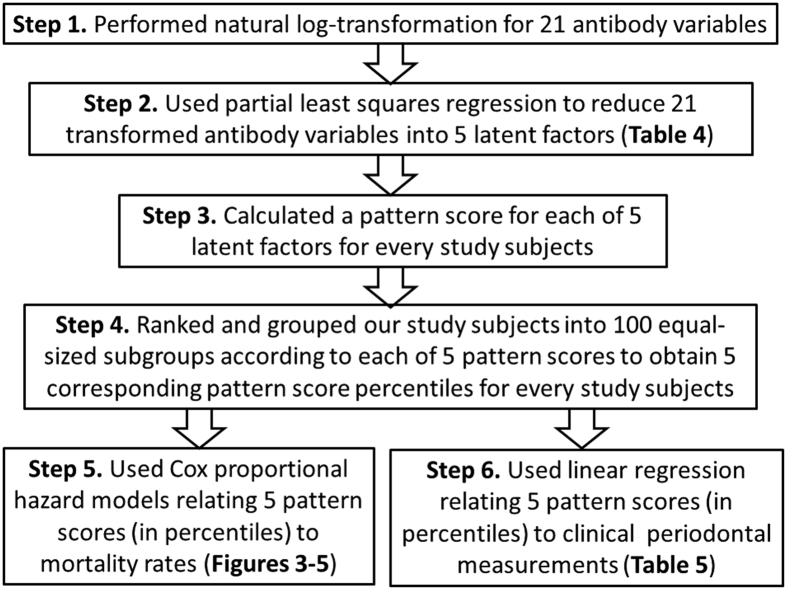
Statistical analysis consists of six steps.Step 1: Log-transformation. Step 2: Periodontal microbiota patterns by partial least squares regression. Step 3: Pattern (latent factor) score calculation. Step 4: Pattern score percentile ranking. Step 5: Periodontal microbiota patterns and mortalities association analysis. Step 6: Periodontal microbiota patterns and clinical periodontal measurements association analysis.